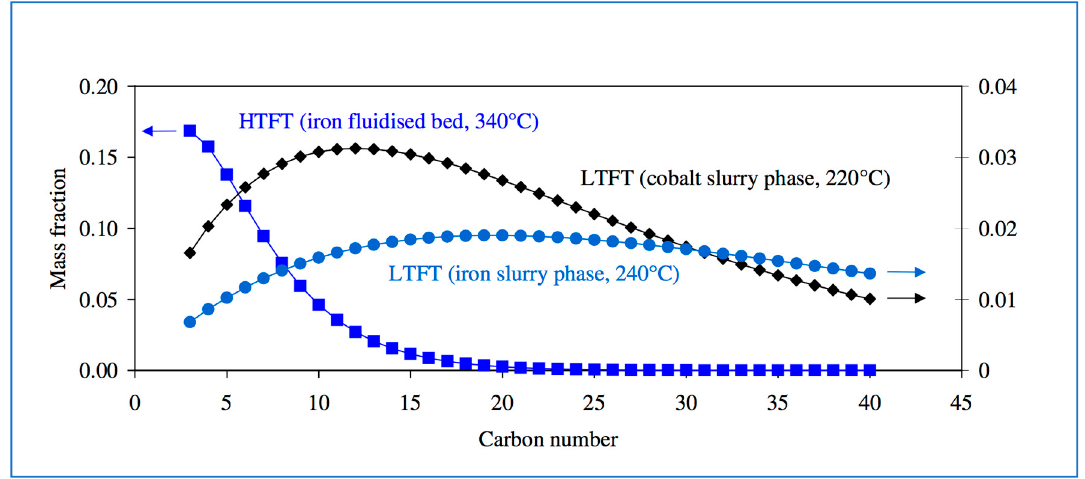
Figure 7. Products distributions for different coal ‐ to ‐ liquid FT processes, catalysts and reactors. Source: Atlantic Consulting.